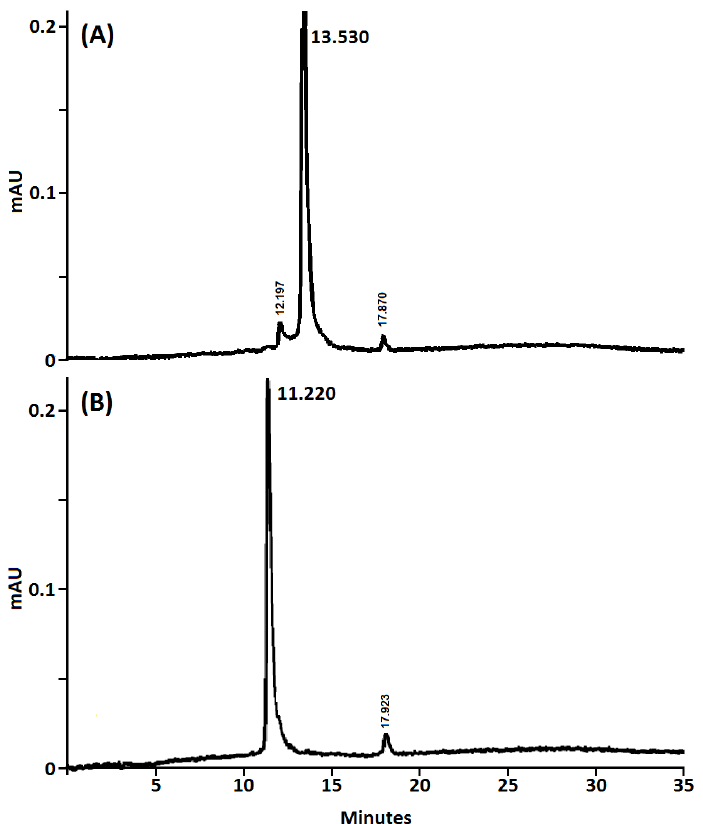
Figure 2. Analytical HPLC chromatograms (UV detection at 420 nm) of ( A ) β-CD@Cur 4 and ( B ) (β-CD) 2 @Cur 5 nanoconjugates (C18 column, ACN/H 2 O containing 0.1% TFA, v/v gradients from 10/90 to 100/0 in 25 min, then 100/0 for 10 min).